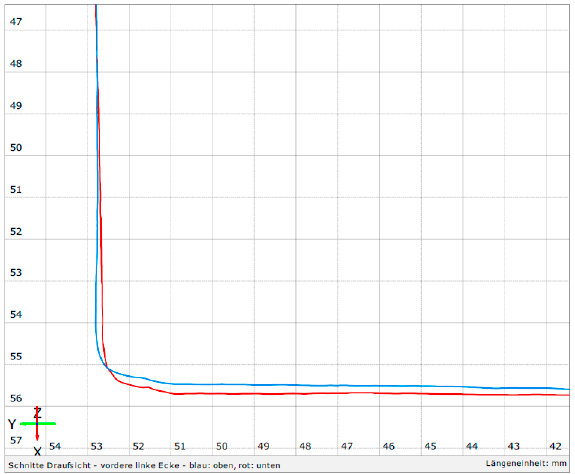
Figure 8. GOM measurement of superimposed planes from top view; manufacturing direction: counterclockwise; solvent debinded.